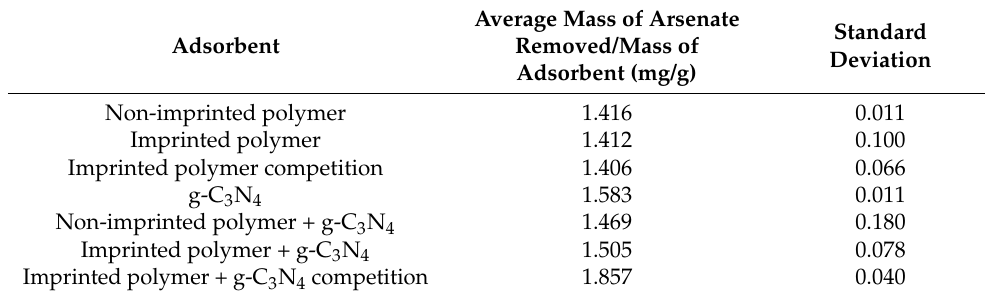
Standard Deviation